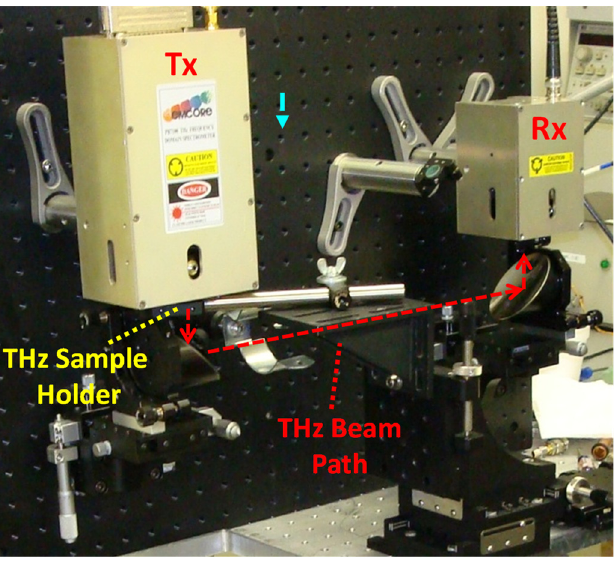
Figure A1. THz photomixing spectrometer with a nanofluidic chip in the beam